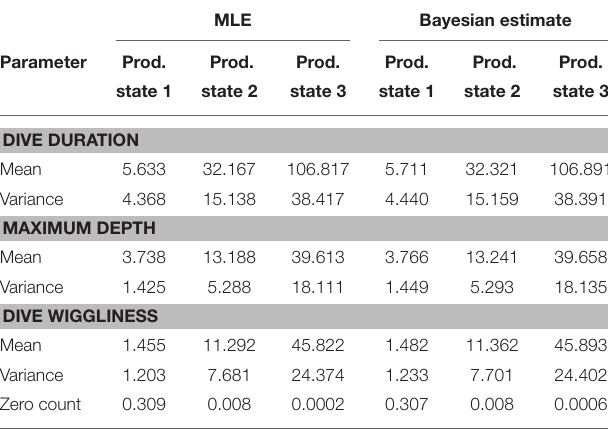
TABLE 2 | Parameter estimates for the three production states, found through Maximum Likelihood Estimation and Bayesian Inference (on the complete collection of parameters).